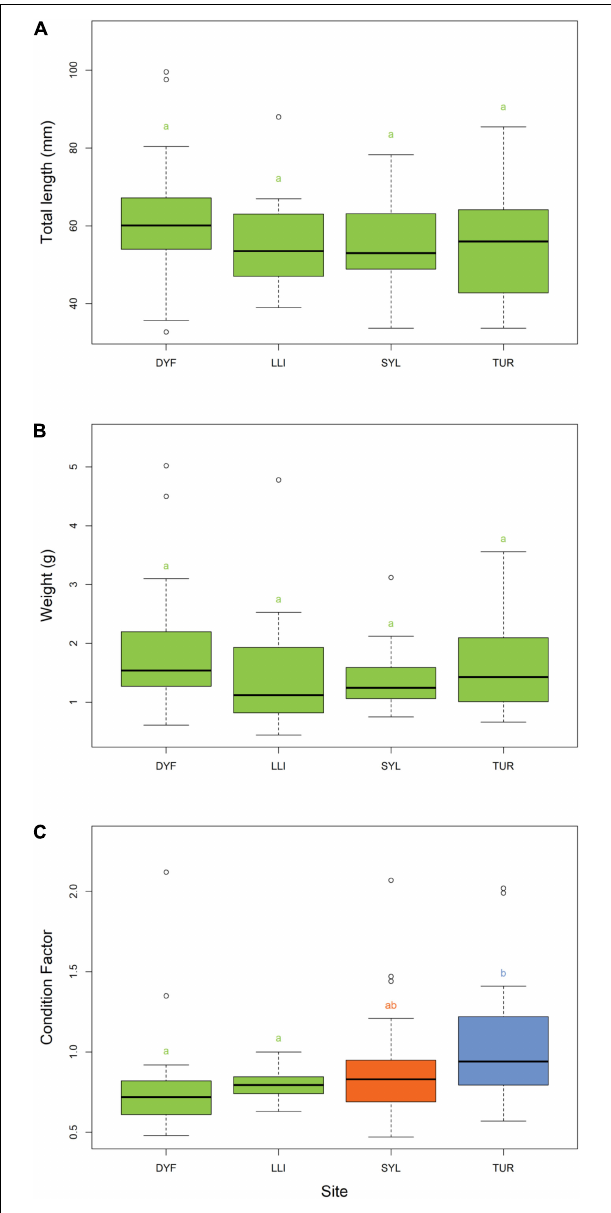
FIGURE 2 | Variation in (A) total length, (B) weight, and (C) Fulton’s body condition factor of topmouth gudgeon across study sites. Sites that have different colors and letter subscripts are statistically different from each other following Tukey’s HSD post-hoc pairwise tests.